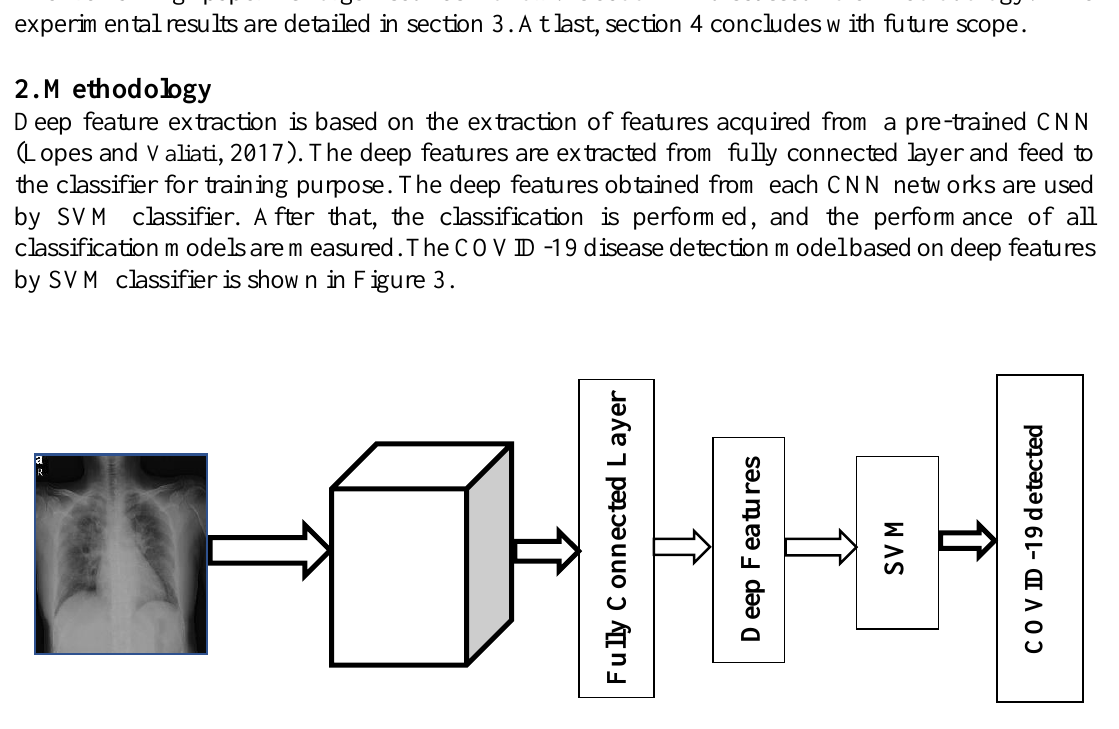
Figure 3. Detection COVID-19 by SVM based on deep feature using X-ray